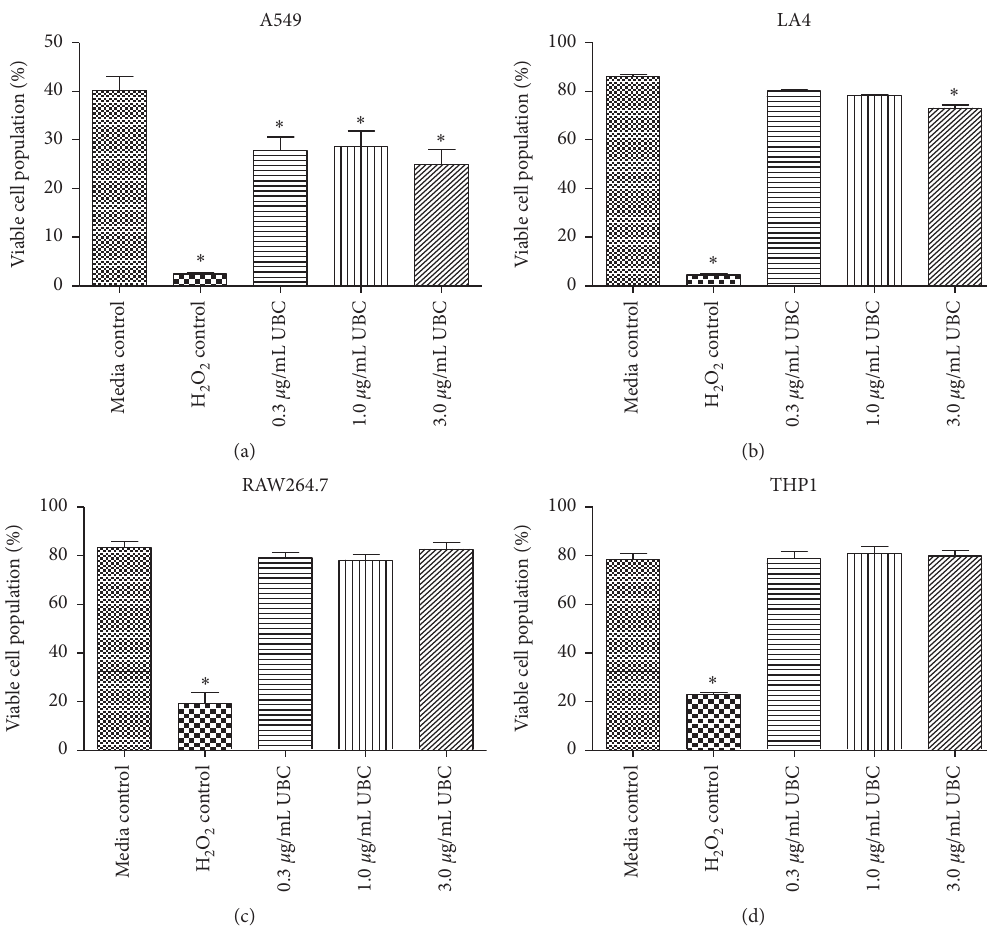
Figure 2: UBC minimally impacts viability as measured by cellular membrane integrity. Cells were treated as described in Methods. These were harvested and cell viability was monitored via flow cytometry as a function of PI after day 9. The number of live cells (viable) is shown as the percentage of PI-negative cells for each cell line ((a), (b), (c), and (d)). Data determined as the mean of six replicates and is representative of three independent experiments. Statistically significant at ∗ p < 0 . 05 in comparison to media controls